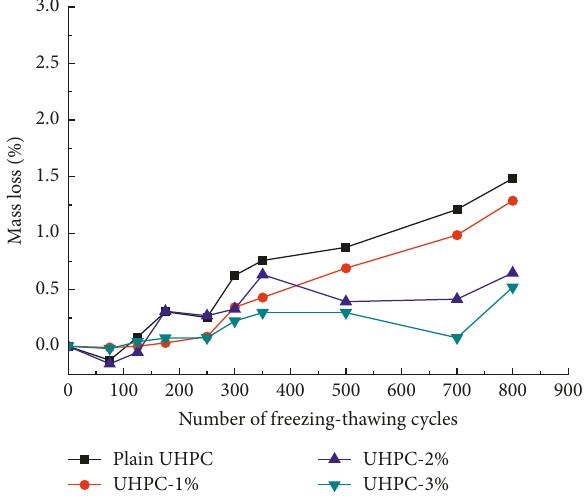
Figure 2: Mass loss of UHPCs at different freezing-thawing cycles.